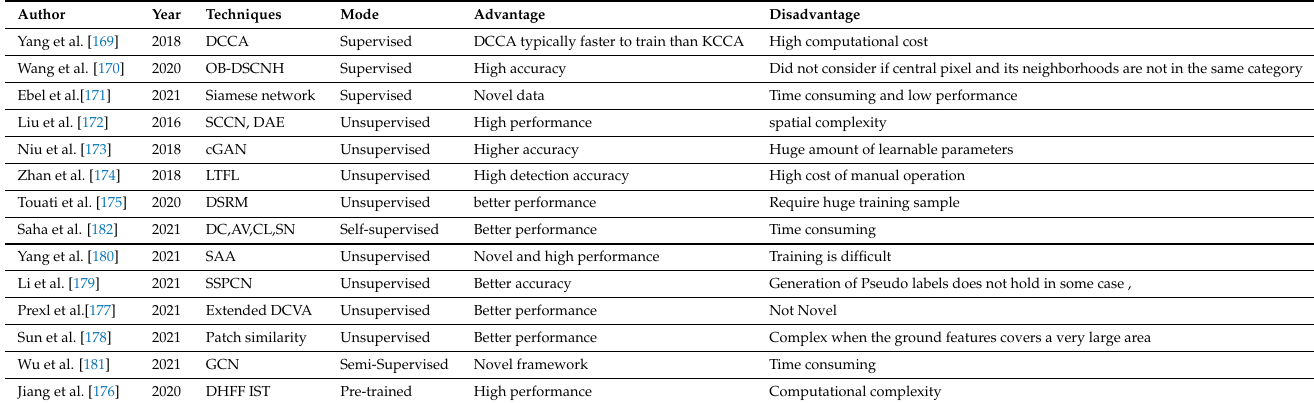
Table 13. Summary of the literature work, of change detection techniques based on the heterogeneous image